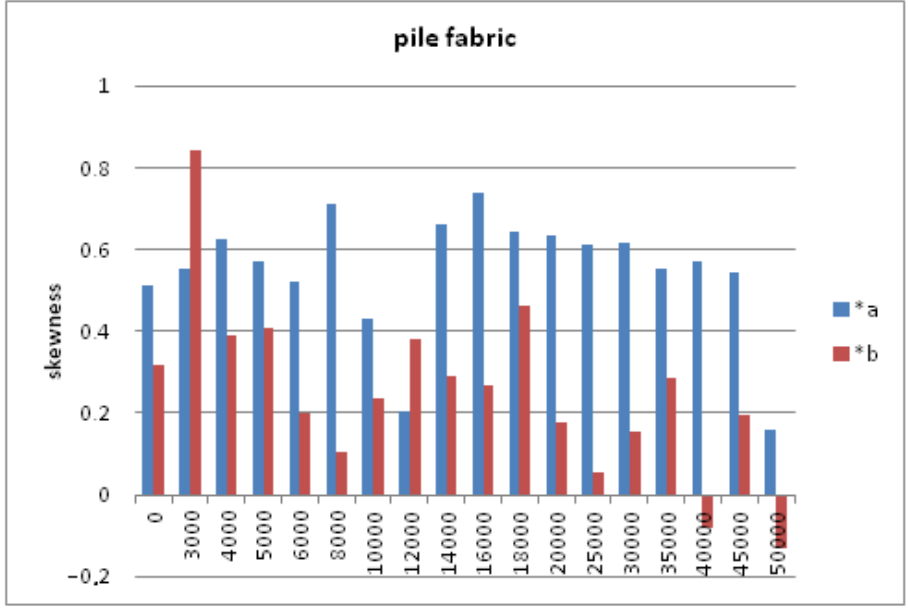
Figure 4. Skewness graph—Fabric